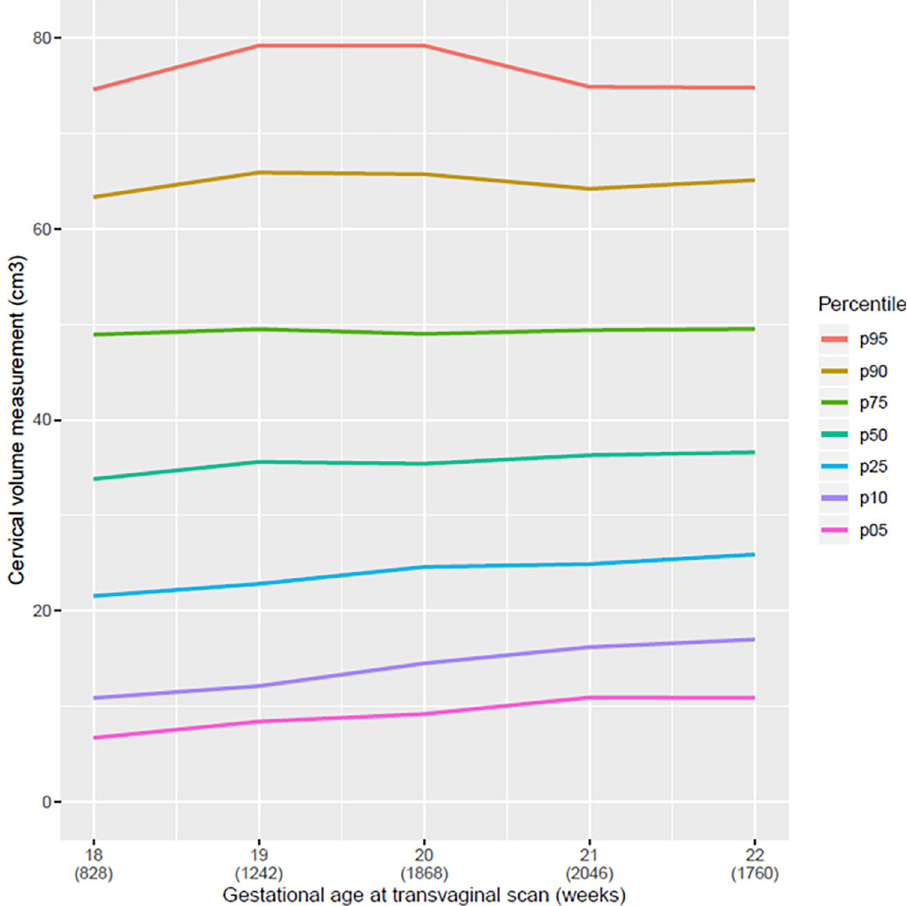
Fig 6. Curve of percentile values for the volume of the uterine cervix according to gestational age (weeks) at transvaginal scan.